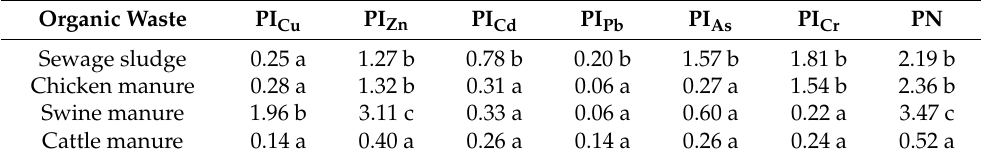
Table 4. Results of single-factor pollution index (PI) and Nemerow’s synthetic pollution index (PN) for heavy metals in agricultural use of sewage sludge and livestock manure. Organic Waste PI Cu PI Zn PI Cd PI Pb Sewage sludge